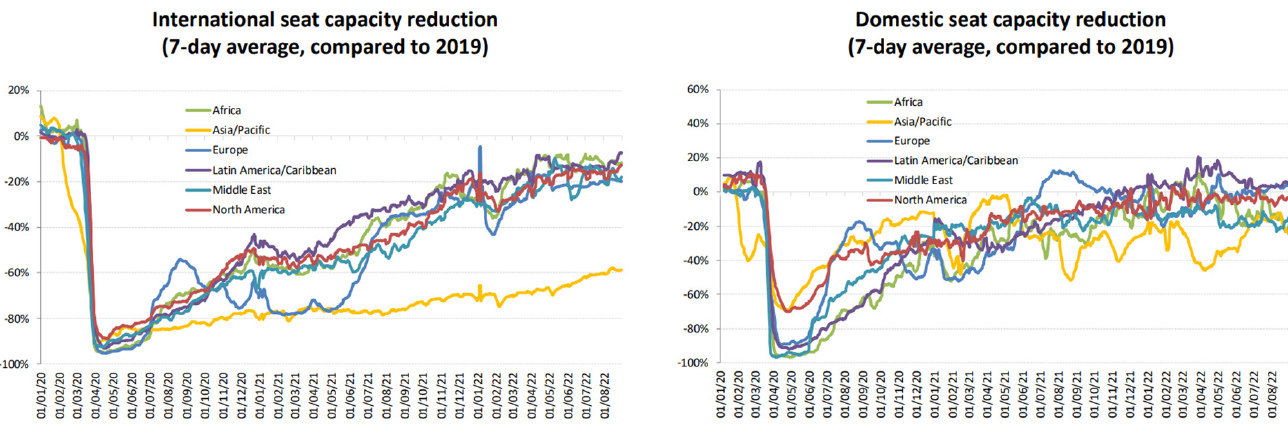
Figure 2. Seven-Day Change (%) vs. 2019 in Onboard Passengers Source: ICAO.